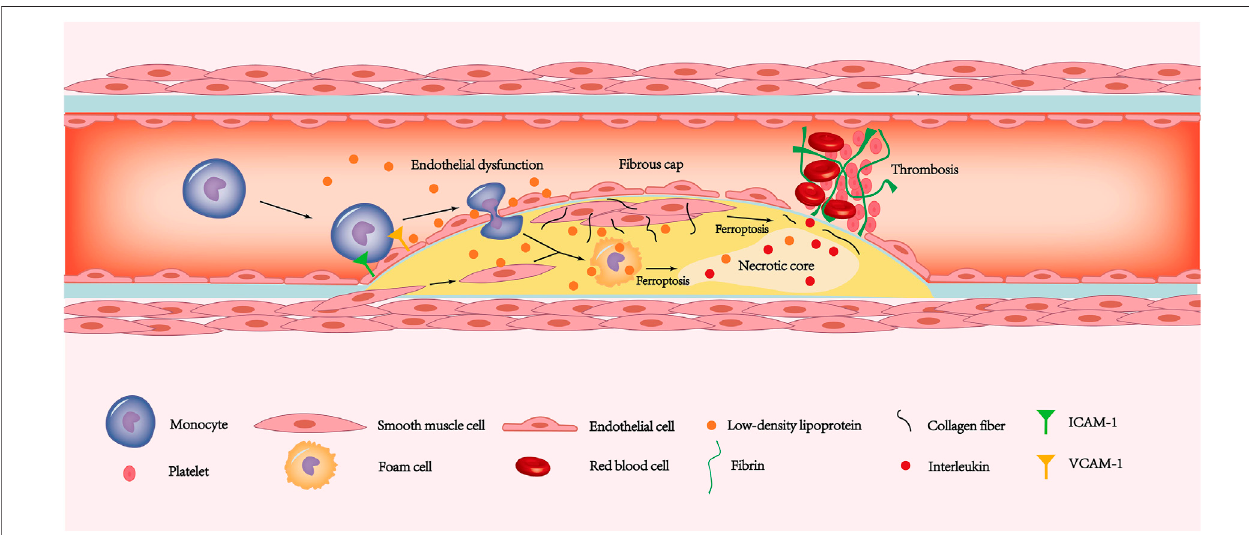
FIGURE 3 | The ferroptosis of endothelial cells, smooth muscle cells and macrophages is involved in the pathogenesis of coronary atherosclerotic heart disease. The increased expression of ICAM-1 and VCAM-1 allows monocytes to adhere to the endothelial surface. Due to ferroptosis leading to endothelial dysfunction, monocyteshavetheopportunitytodeformandentertheinnermembrane.Themonocytesundertheinnermembranegraduallytransformintomacrophages.Thensome macrophages and smooth muscle cells phagocytose LDL and then form foam cells. In addition, some smooth muscle cells migrate to the plaque surface and secrete a large amount of extracellular matrix such as collagen fi bers, forming thick fi brous caps. As the disease progresses, ferroptosis in smooth muscle cells leads to gradual thinning of the fi brous cap. Similarly, foam cells ferroptosis promotes the release of interleukins in the necrotic core. Exfoliation of the endothelium caused by ferroptosis exposes fi brinogen to the tissue. The combination of thin fi brous caps, endothelialstripping, and large amounts of interleukin released from the necrotic core leads to a rapidly forming thrombosis that blocks the coronary artery and causes ACS. LDL, low-density lipoprotein; ACS, acute coronary